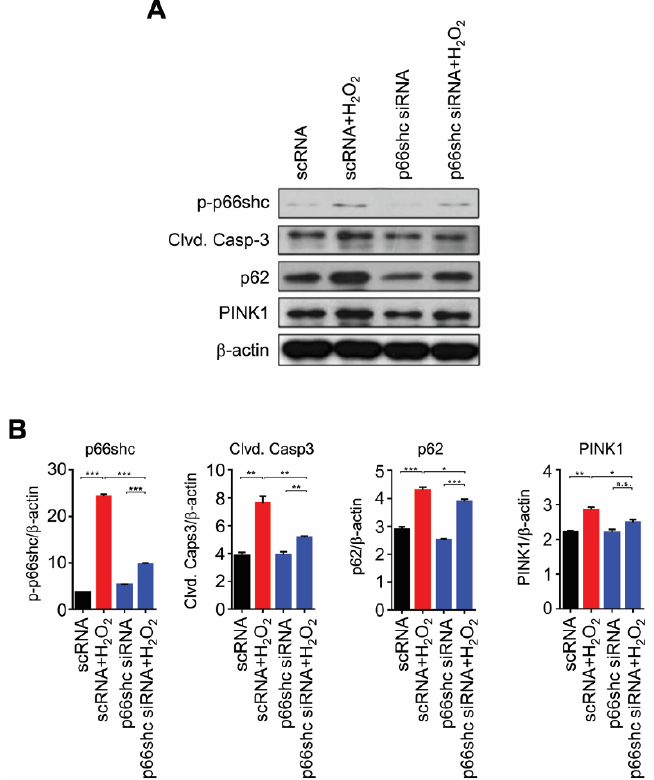
Figure 5. Reduced expression of markers of apoptosis, autophagy, and mitophagy after p66shc